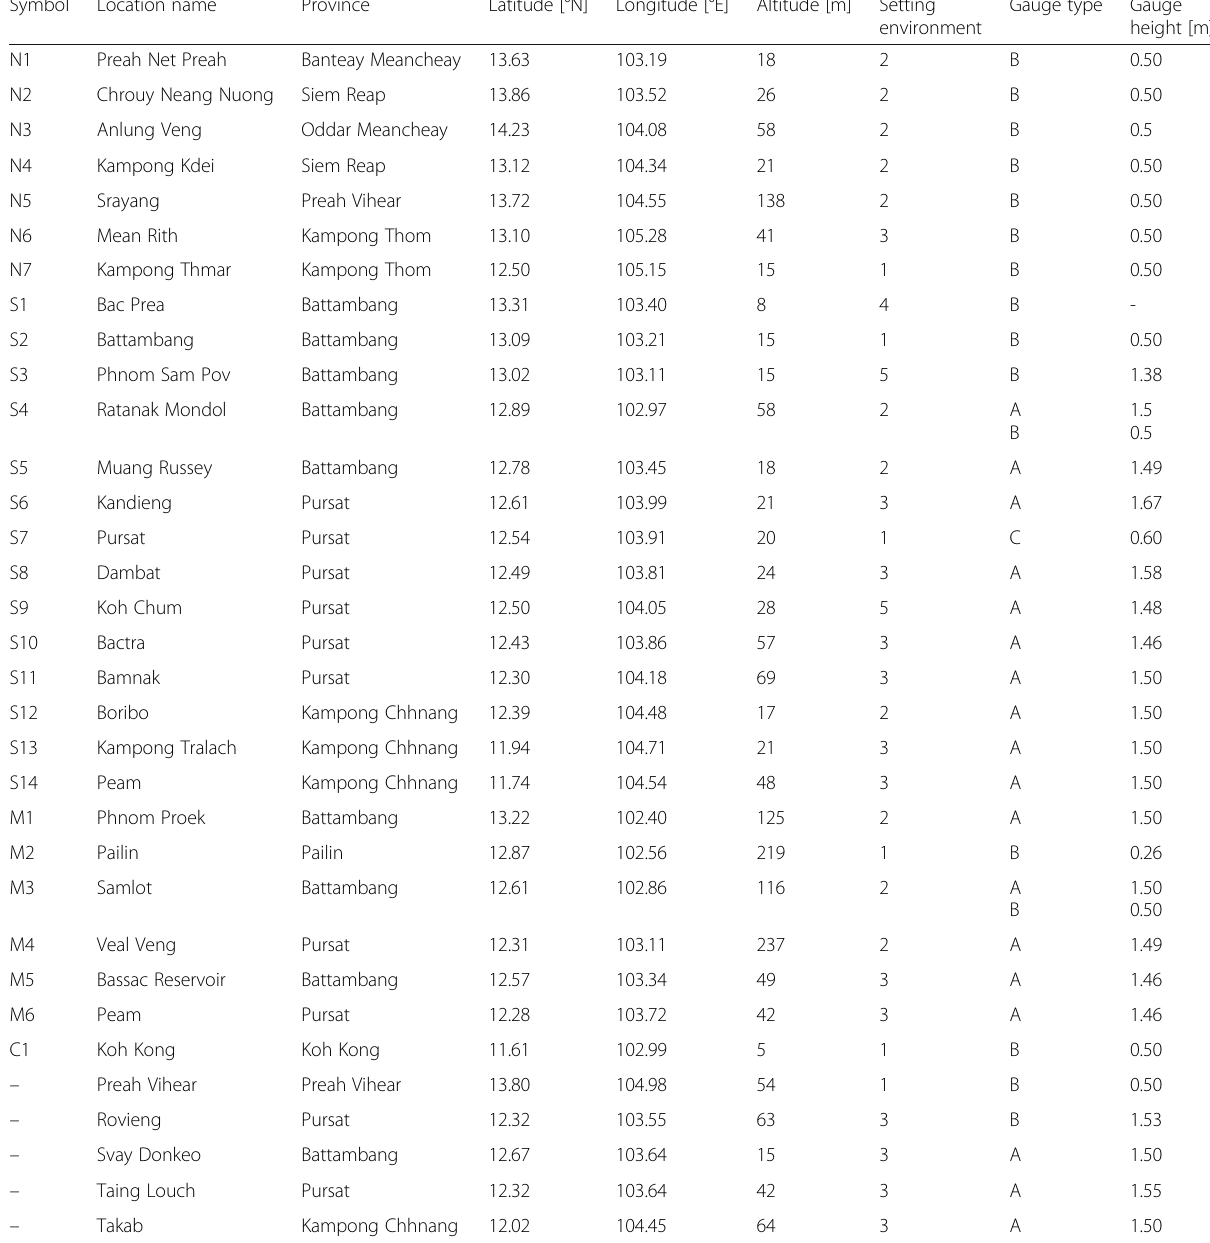
Table 1 Specification of each station and its gauge used in the analysis Symbol Location